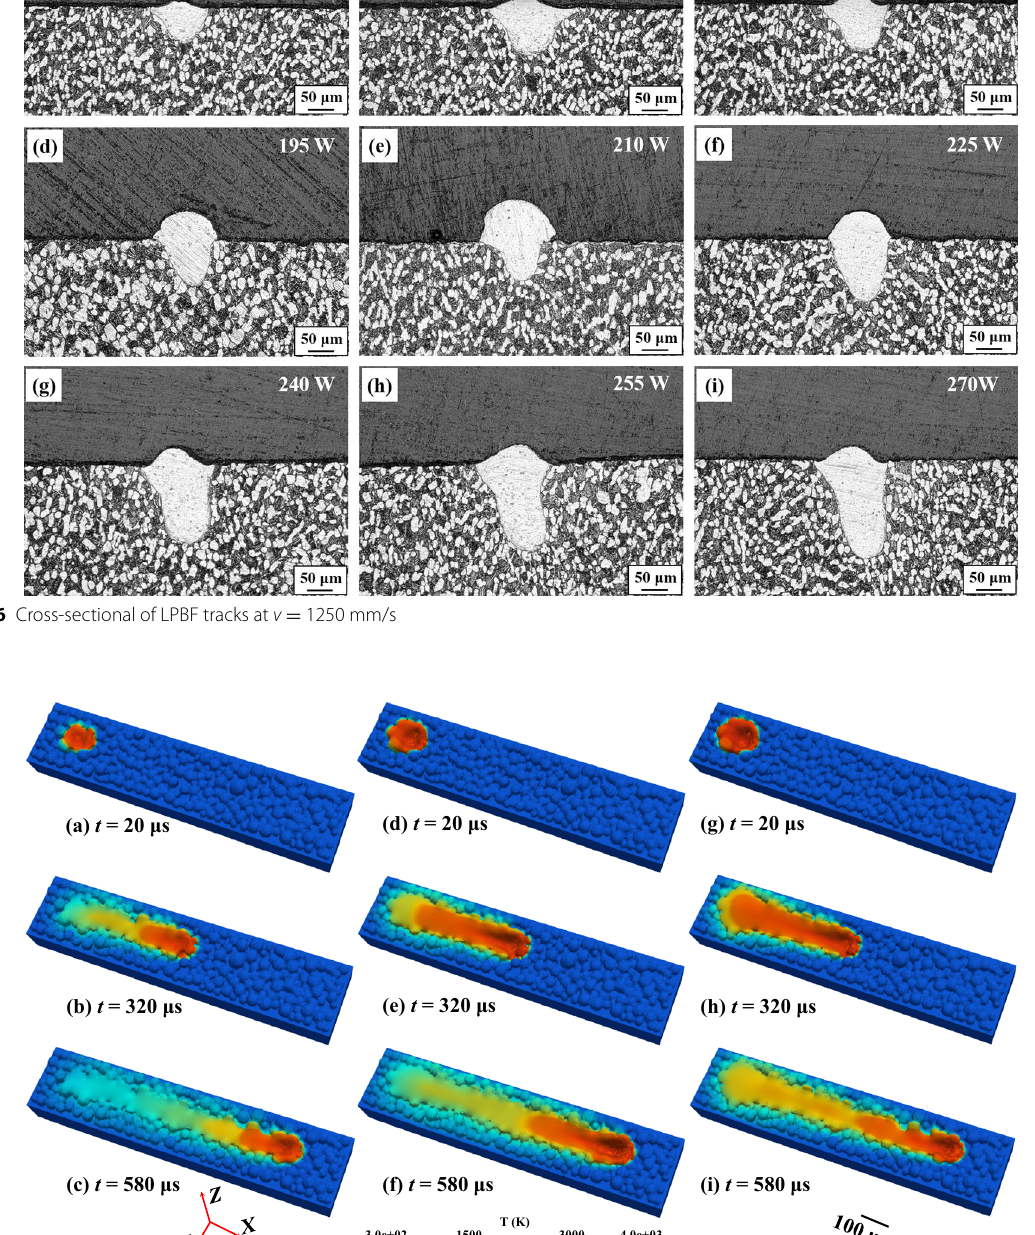
Figure 7 Simulation results of LPBF tracks: a – c 150 W, d – f 195 W, g – i 255